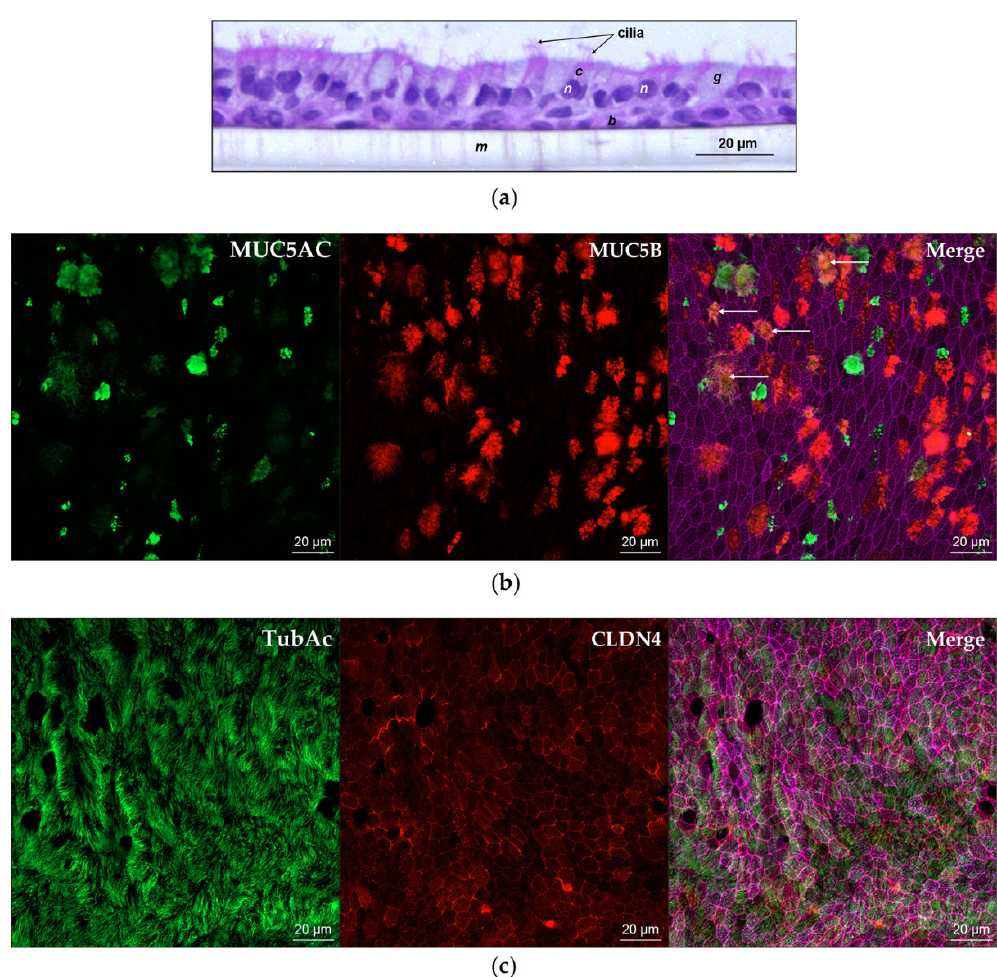
Figure 1. Characterization of wdNHBE cells by histology and immunocytochemistry. ( a ) Hematoxylin and eosin staining of a transverse section of NHBE cells di ff erentiated at the air liquid interface on the apical surface of a transwell membrane. Nuclei ( n ) are stained purple and membranes, cytoplasm and cilia are stained pink. Basal cells ( b ), ciliated cells ( c ) with surface cilia, goblet cells ( g ) and the porous polyester transwell membrane ( m ). ( b ) En face images of wdNHBE cells stained with MUC5AC (green, goblet cells) and MUC5B (red, secretory cells). The Merge of MUC5AC, MUC5B and phalloidin (F-actin)-stained cytoskeleton (pink) depicts the partial colocalization of MUC5AC and MUC5B secretion (yellow, indicated by arrows). En face Z-stacks of 19 slices (9 µ m) were captured using a 40x oil immersion objective and maximum intensity projections generated, 20 µ m scale bars indicate cell size. ( c ) Confocal microscopy of wdNHBE cells stained with acetylated tubulin (TubAc, green, cilia on the surface of ciliated cells) and CLDN4 (red, tight junctions). Merge of TubAc, CLDN4 and F-actin. Maximum intensity projections of en face Z-stacks, 19 slices (9 µ m) imaged using a 40x oil immersion objective with 20 µ m scale bars are